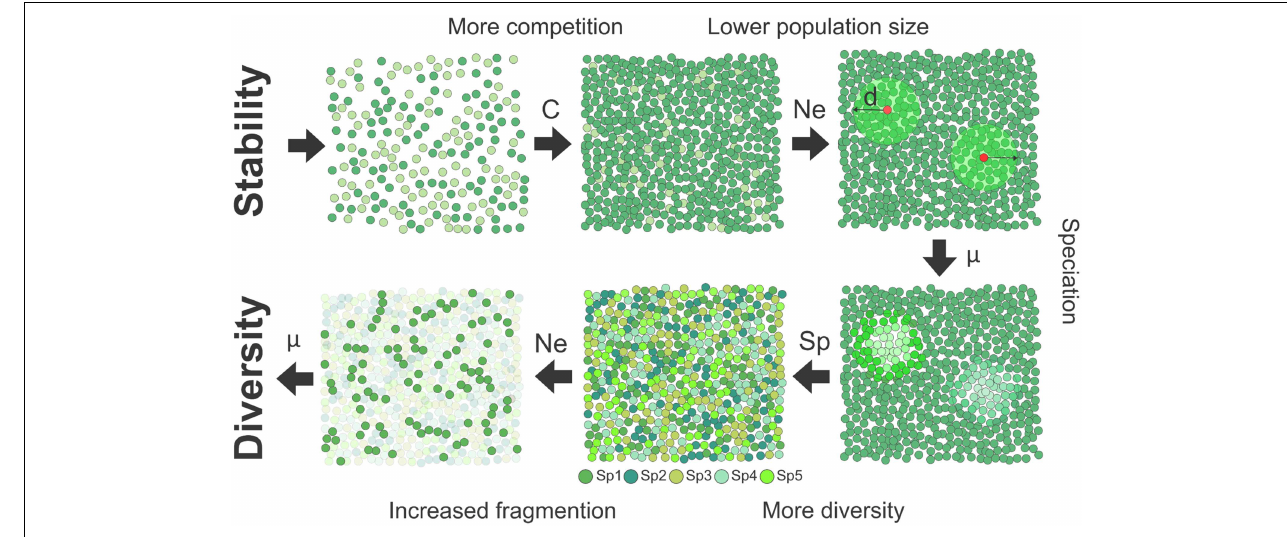
effective population size ( Ne ). In smaller populations, higher fixation rate of molecular substitutions ( µ ) increases the likelihood of speciation events. Higher diversity further promotes diversity since the presence of more species increases spatial structuring of populations, favoring genetic differentiation, and